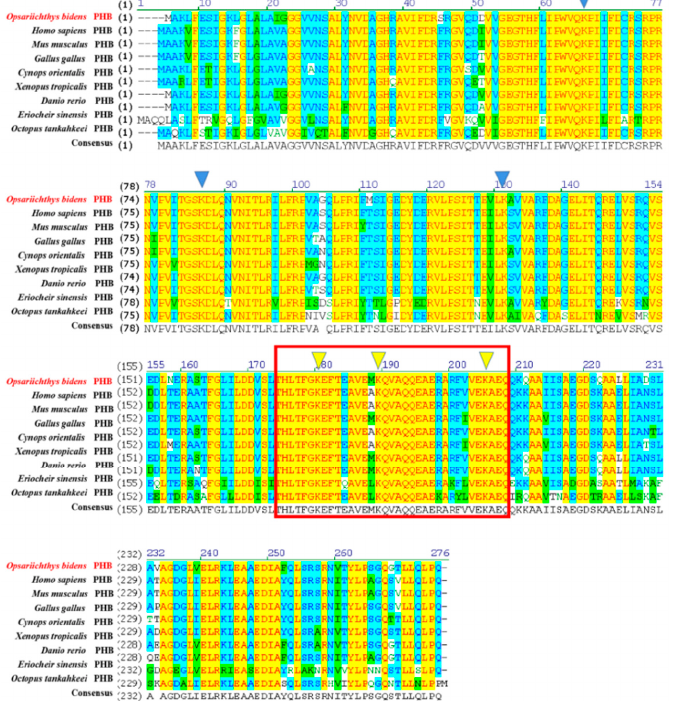
Figure 5. Sequence alignment of the PHB protein among O. bidens and other species. The red box shows highly conserved PHB fragments among species, and the yellow arrow marks the conserved tyrosine site. PHB protein sequence identities between O. bidens PHB and H. sapiens , M. musculus , G. gallus , C. orientalis , X. tropicalis , D. rerio , E. sinensis , and O. tankahkeei were 90.1%, 89.7%, 89.3%, 90.1%, 88.2%, 97.0%, 84.7% and